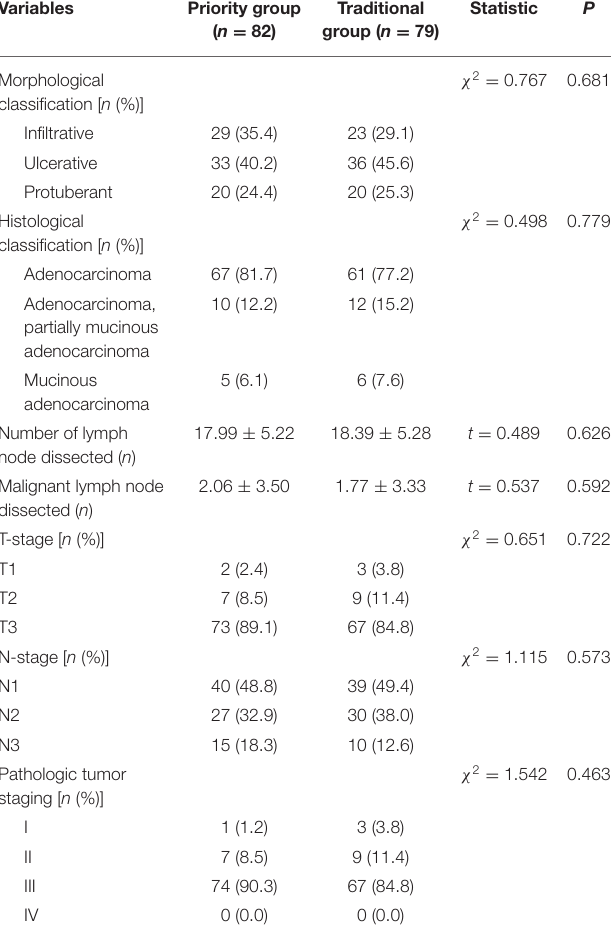
TABLE 3 | Postoperative findings from pathological examination.